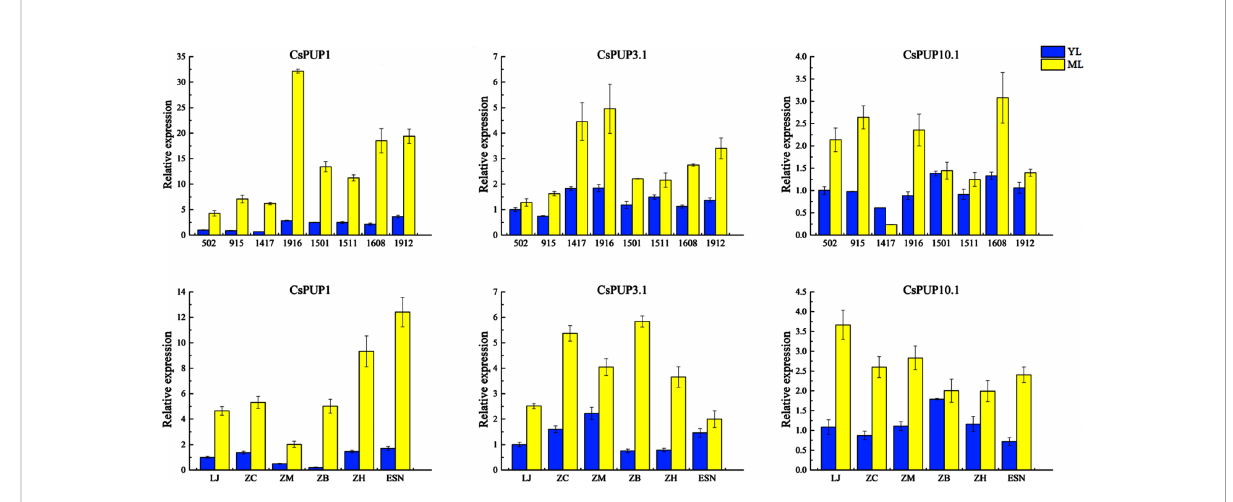
FIGURE 6 Expression levels of CsPUP1, CsPUP3.1 and CsPUP10.1 in different tea strains and